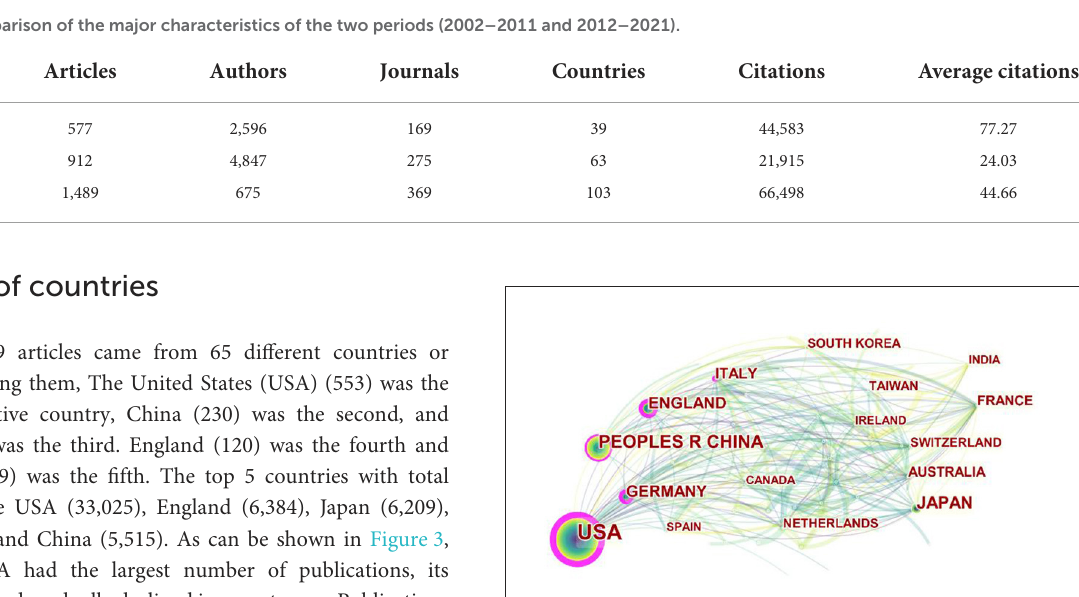
FIGURE3 The cooperation network map of countries related to MSCs in orthopedics from 2002–2021. Node size represents the number of output. The thicker the pink outer ring of the node, the higher the